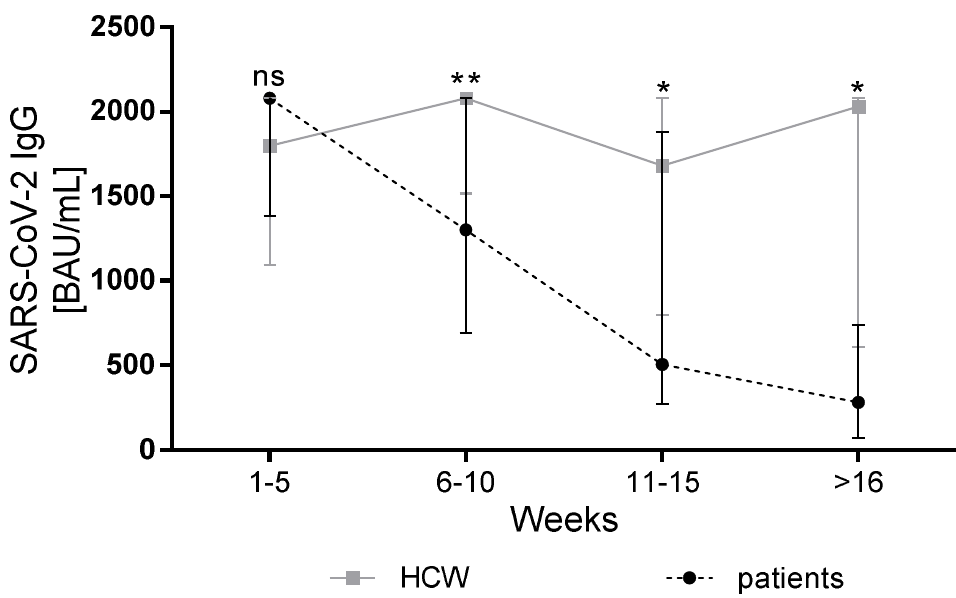
Figure 1. SARS-CoV-2 IgG titer in relation to the time point between the second dose and antibody detection. A comparison of the binding antibody units per milliliter (BAU/mL) ratio of SARS-CoV-2 IgG antibodies of patients with liver cirrhosis and HCWs at different times after the second dose. Patients and HCWs were grouped based on the weeks between the second dose and antibody detec- tion. The medians are illustrated with the corresponding interquartile ranges. BAU: binding antibody units; HCW: healthcare worker; SARS-CoV-2: severe acute respiratory syndrome coronavirus type 2; ns: no significance, * p ≤ 0.05; ** p ≤ 0.01.